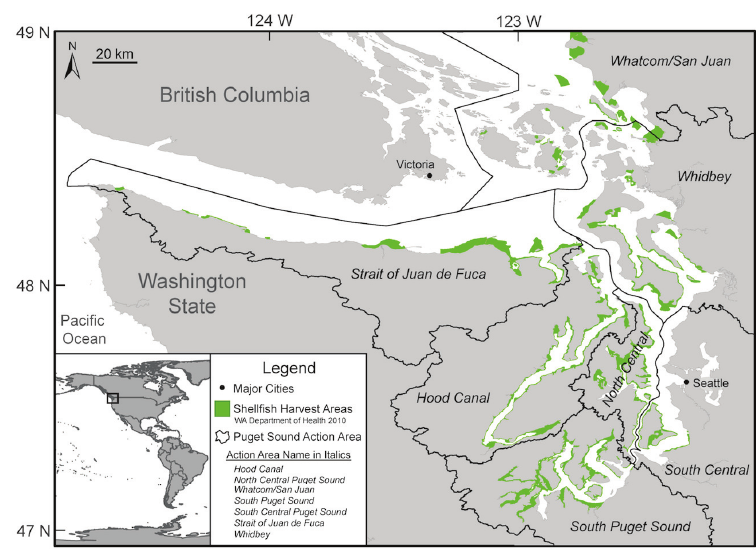
Figure 2. Puget Sound Action Areas and commercial shellfish growing areas. Boundaries of the Puget Sound Action Areas, each of which represent a unique watershed and harvest region as designated by the Puget Sound Partnership 56 . Washington State Department of Health’s approved commercial shellfish growing areas for 2010 57 are highlighted in green. Included in this study are data on shellfish harvest biomass and revenue from all Action Areas except South Central Puget Sound. farms where they are grown directly on mudflats, on racks sit- ting on the bottom substrate, or suspended under floating rafts.